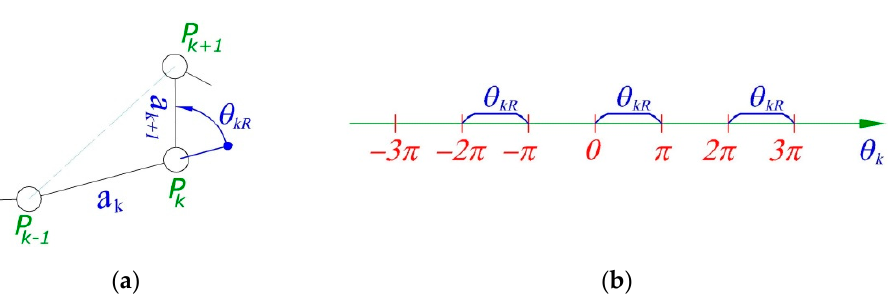
Figure 3. ( a ) Right-hand relative configuration R between two links of a serial robot. ( b ) Intervals in which the angle θ k changes in the right-hand configuration represented on a numerical axis.